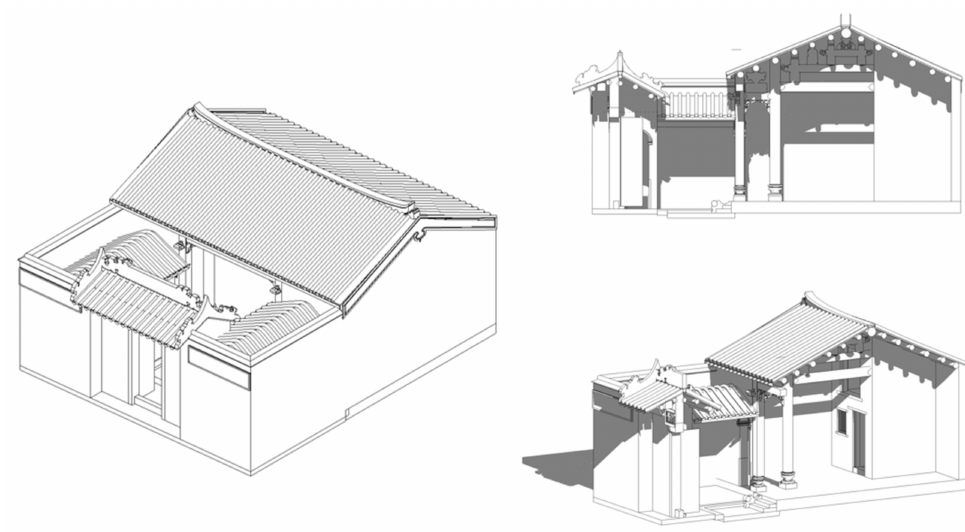
Figure 12. Bird’s-eye view ( left ), section view ( upper right ), and section view ( lower right ) of Sisheng Hall.